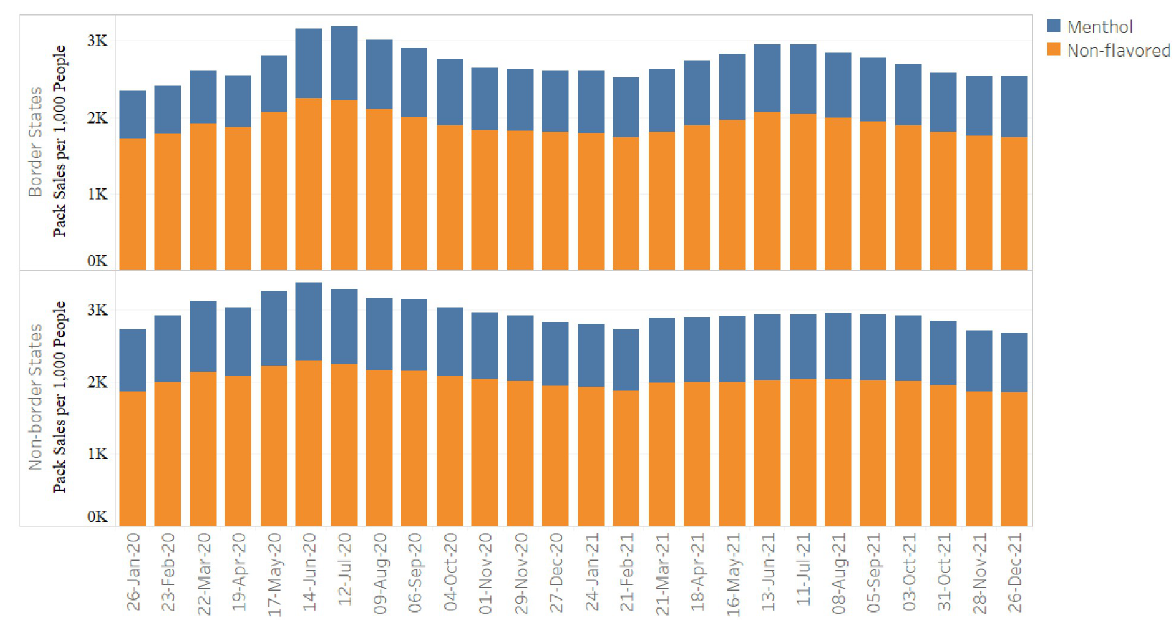
Fig 2. Sales of cigarette packs, a by flavor, in border versus non-border states, b January 2020-December 2021 c . a Retail sales data were obtained from Information Resources, Inc. (IRI) for convenience stores, gas stations, grocery stores, drugstores/pharmacies, mass merchandiser outlets, club stores, dollar stores, and military sales. Unit sales were standardized by one pack of 20 cigarettes. b The list of border states included New Hampshire, Connecticut, Vermont, and Rhode Island. The list of non-border states included the following 28 states: Alabama, Arizona, Arkansas,